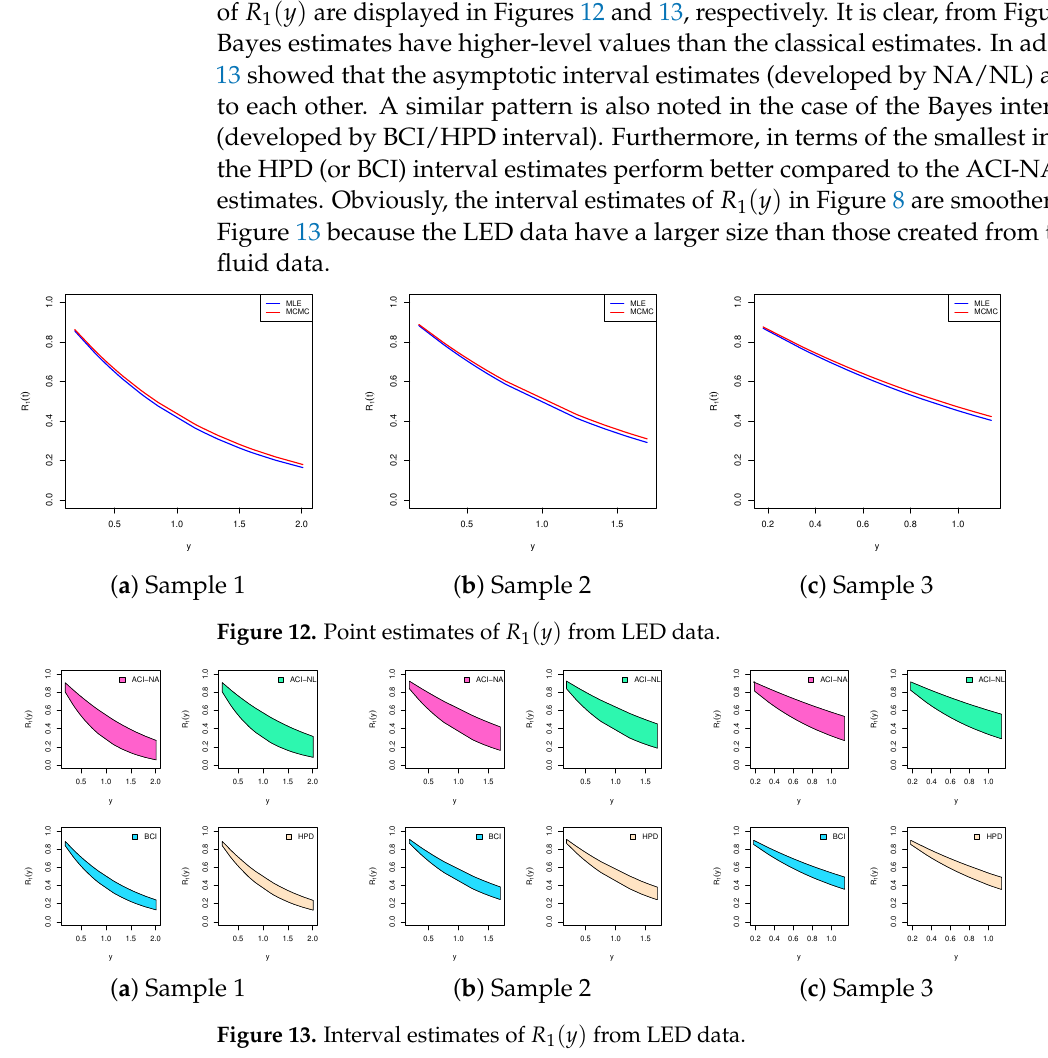
Figure 13. Interval estimates of R 1 ( y ) from LED